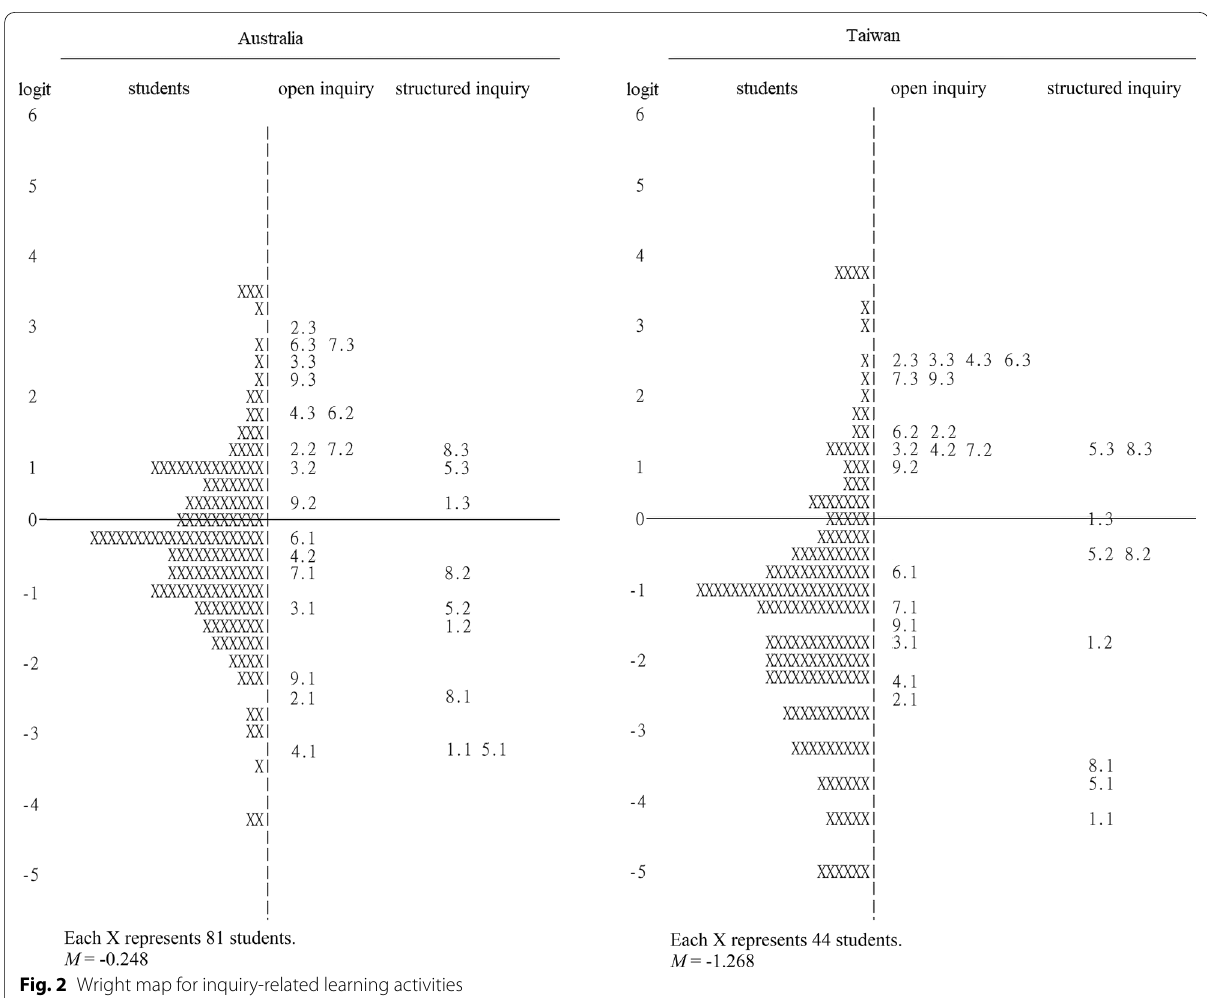
Fig. 2 Wright map for inquiry‑related learning